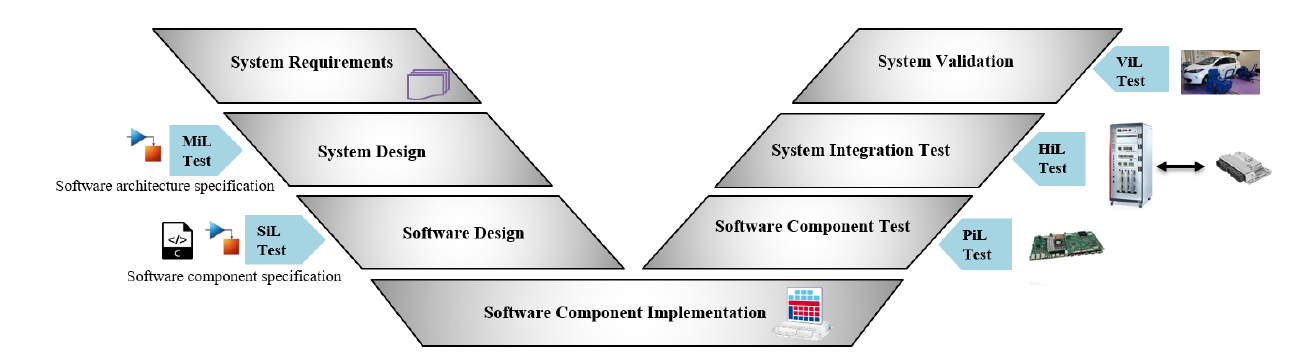
Figure 1. V-cycle of model-based software development process with the test